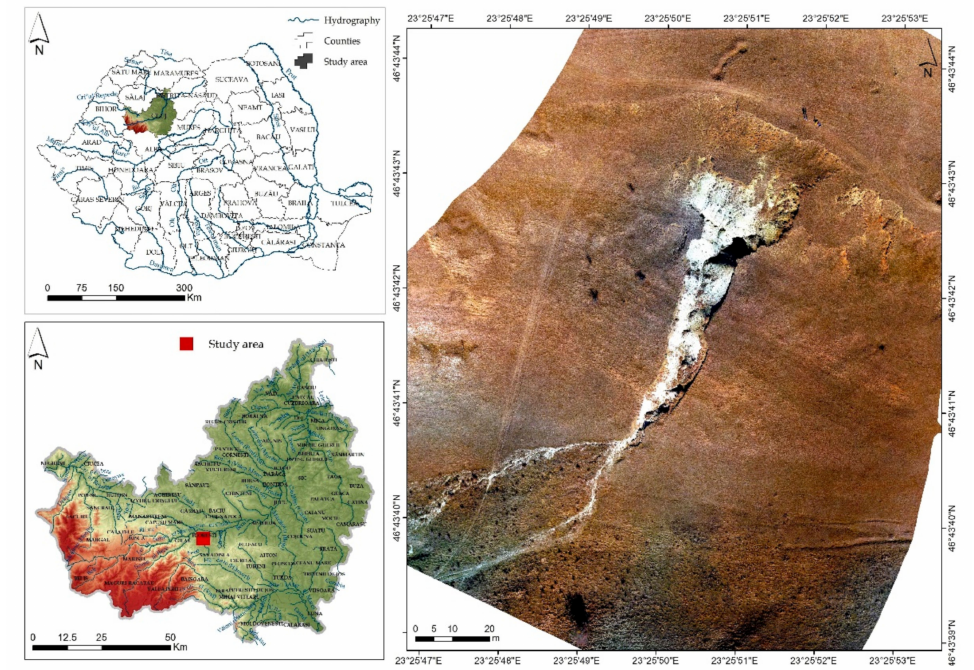
Figure 1. Geographical position of the study